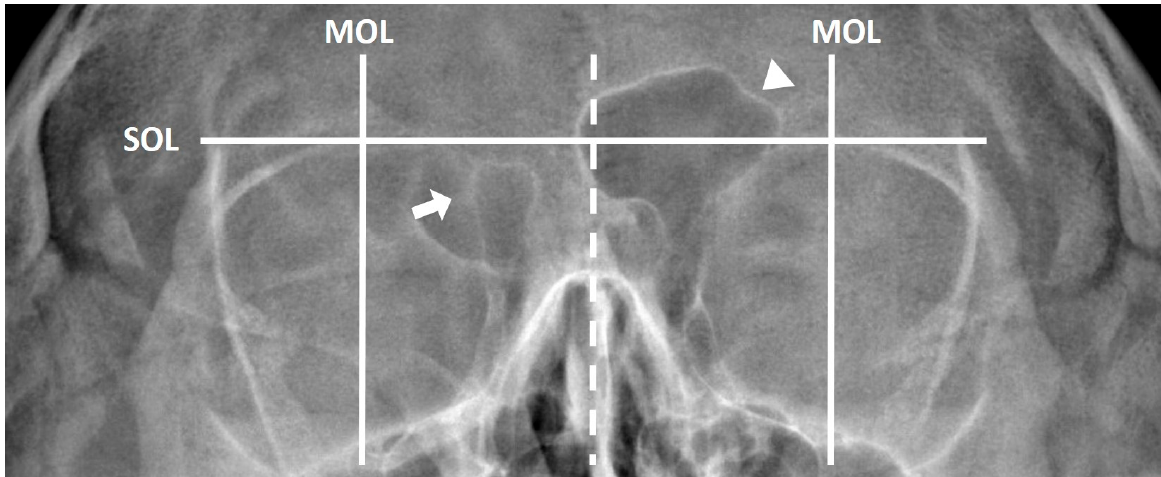
Figure 1. Frontal sinus hypoplasia (arrowhead): a sinus with an oval shape, with the lateral margin lying medial to a vertical line drawn through the middle of the orbit, with a smooth superior margin, and without sinus septa. Frontal sinus aplasia (arrow): absence of frontal bone pneumatization without ethmoid cells extending above the tangential line to the supraorbital margin (orbital roof). SOL, superior orbital line; MOL, middle orbital line.